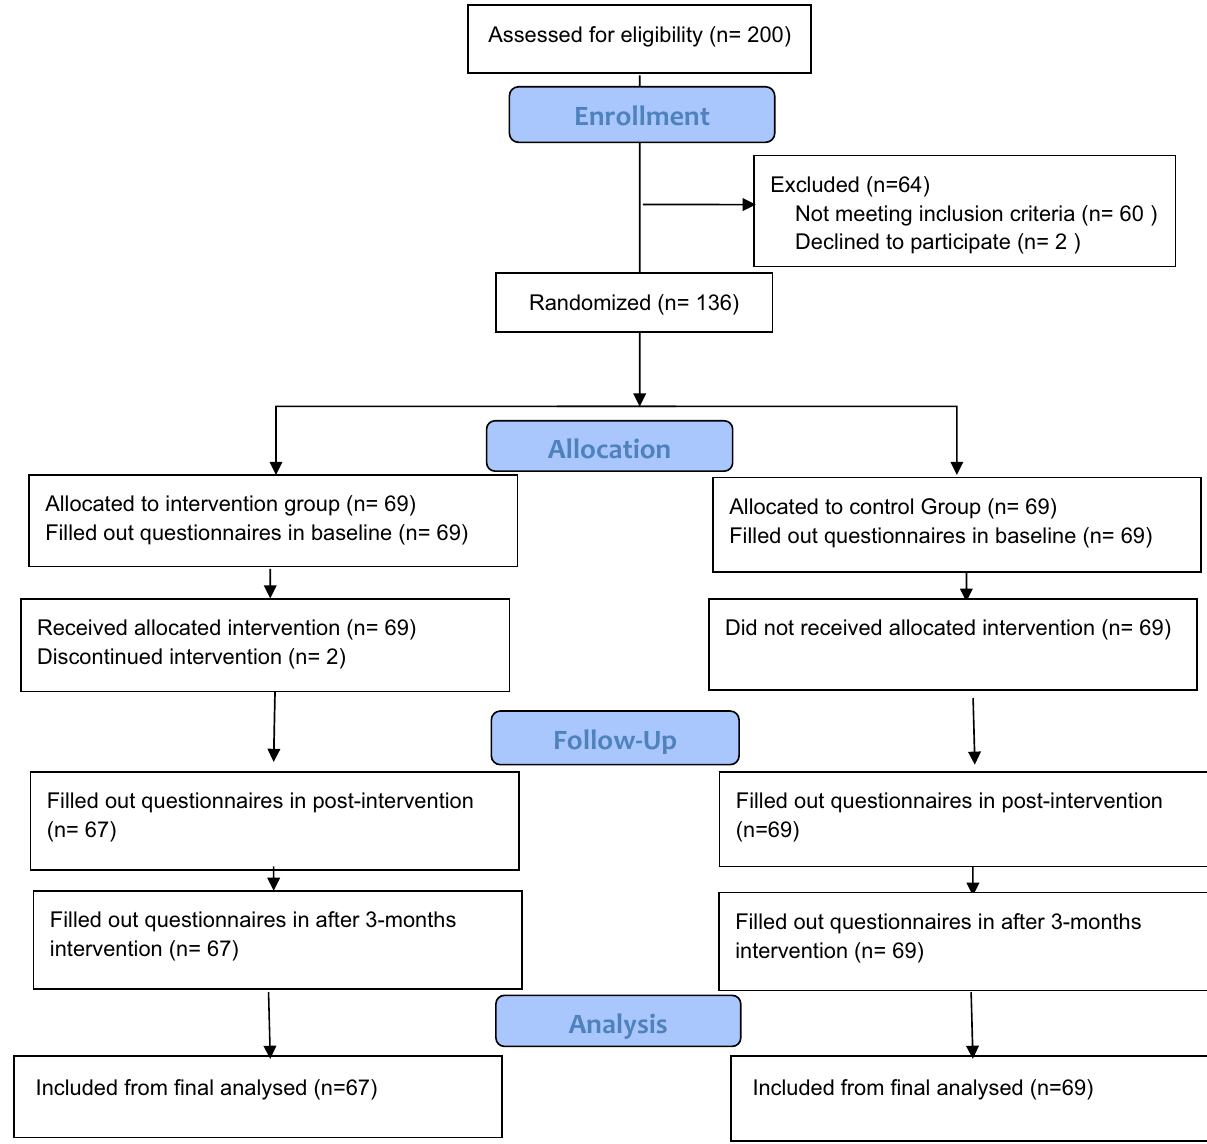
Figure 1. Flow of participants through each stage of the